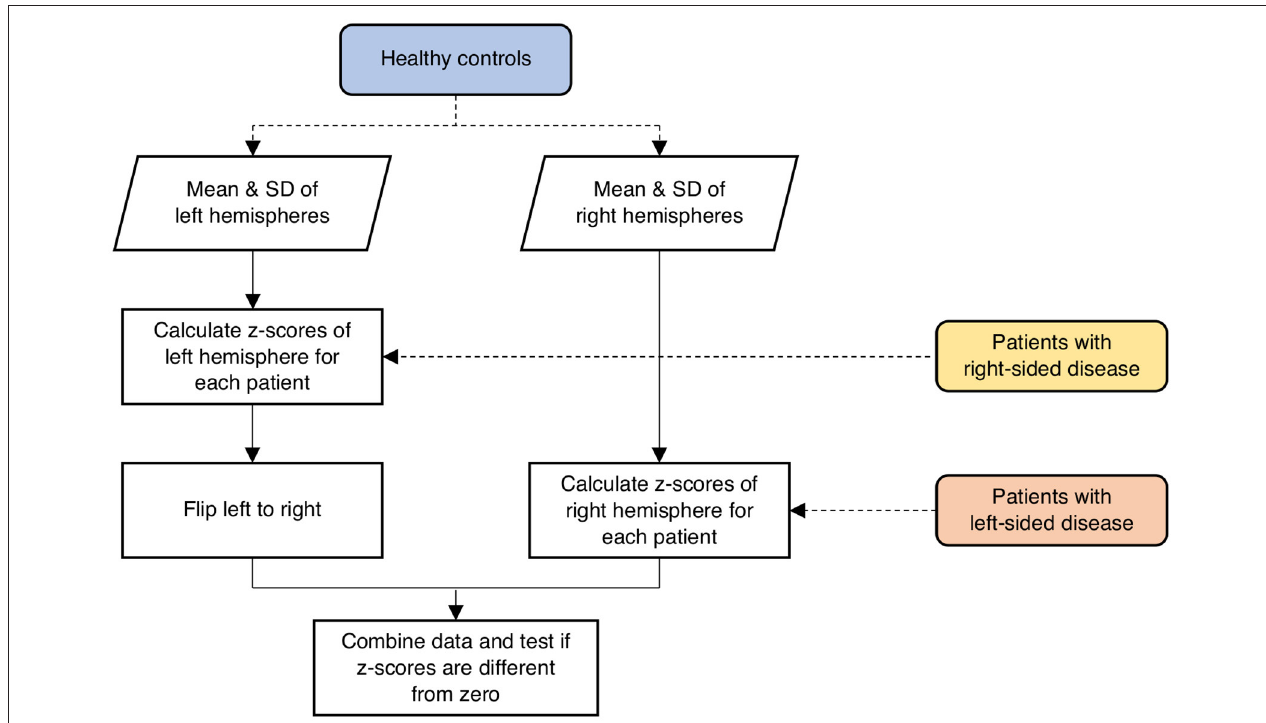
FIGURE 1 | Schematic illustration of the procedure involved in calculating z -scores of network parameters in the contralateral hemispheres of the patients relative to the respective hemispheres of the healthy controls. SD, standard deviation.